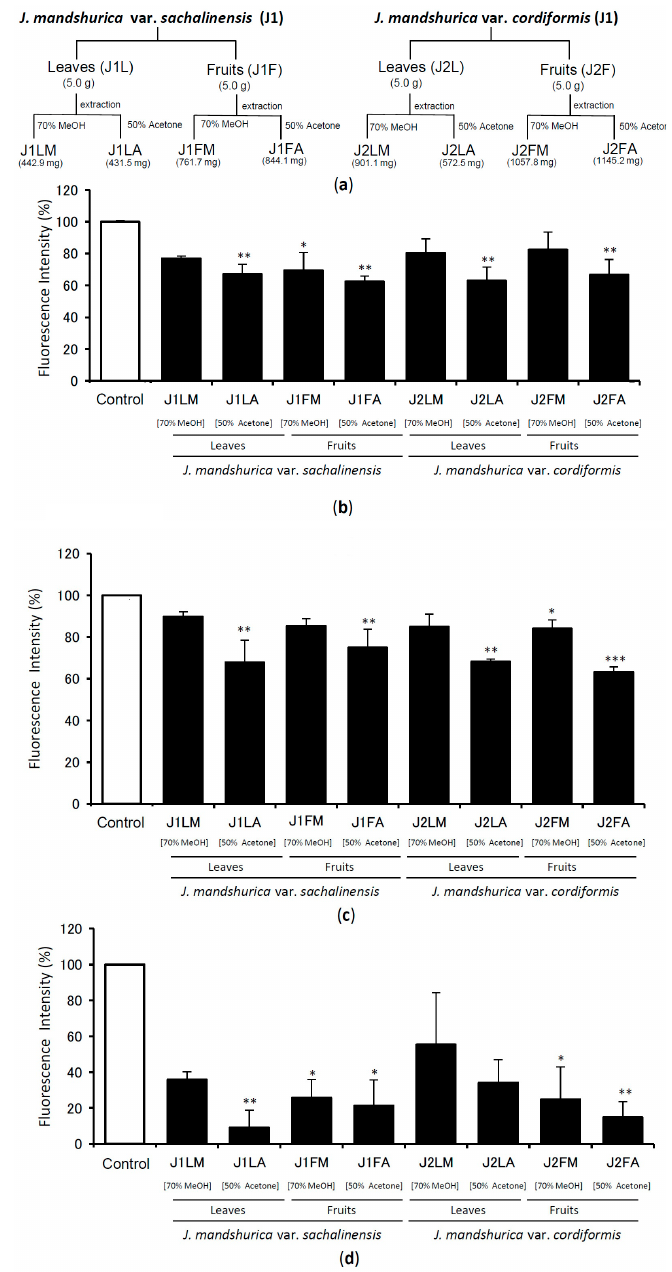
Figure 2. The extraction of leaves and immature fruits of J. mandshurica var. sachalinensis and J. mandshurica var. cordiformis with 70% methanol and 50% acetone at room temperature ( a ). The amyloid fibril disrupting activity of different extracts (0.5 mg/mL) when incubated with V30M-TTR tetramer ( b ) and WT-TTR tetramer ( c ) for 24 h, then quantified with ThT assay. Quantification was performed by with PROTEOSTAT ® Protein Aggregation Assay following similar procedure using V30M-TTR ( d ). Data sets were analyzed by Tukey-Kramer multiple comparison test. * p < 0.05; ** p < 0.01; *** p < 0.001 as compared with control (respective TTR treated with DMSO in each experiment); All experiments were performed in triplicate (means ± SEM, n =